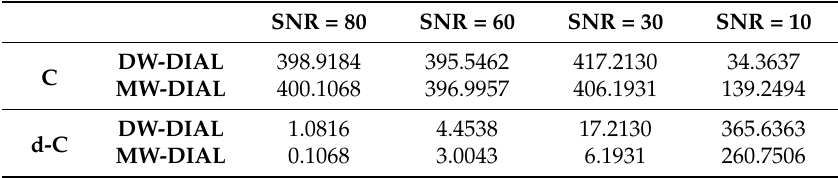
Table 7. Comparison of the inversion results by DW-DIAL and MW-DIAL (unit: ppm). SNR =